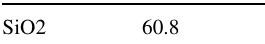
Fig. 3 Image for IFT test